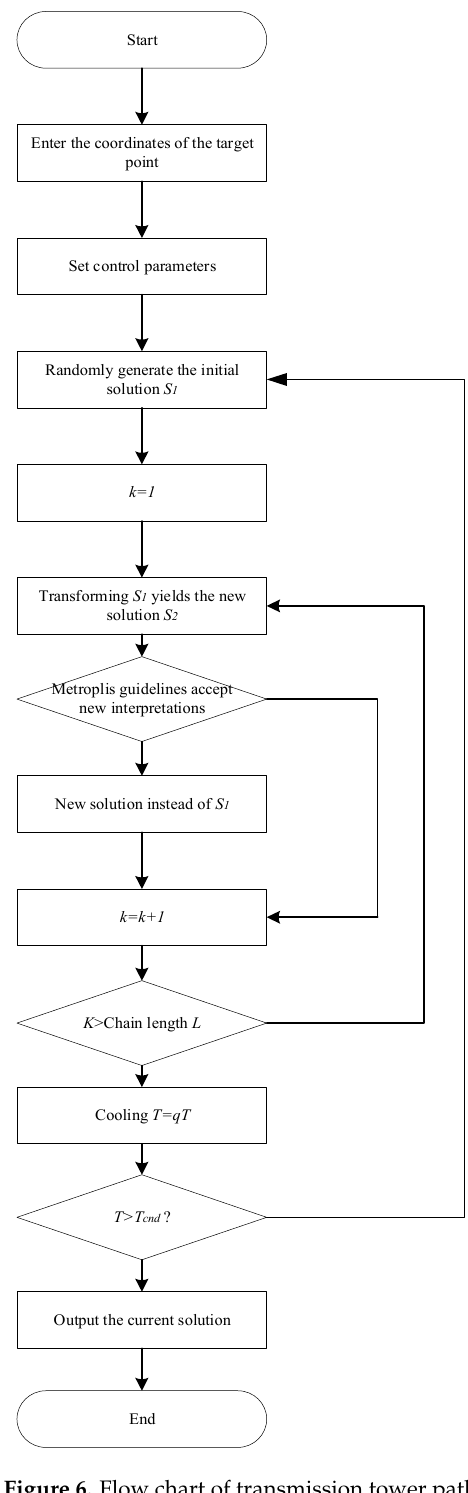
Figure 6. Flow chart of transmission tower path planning algorithm solution.